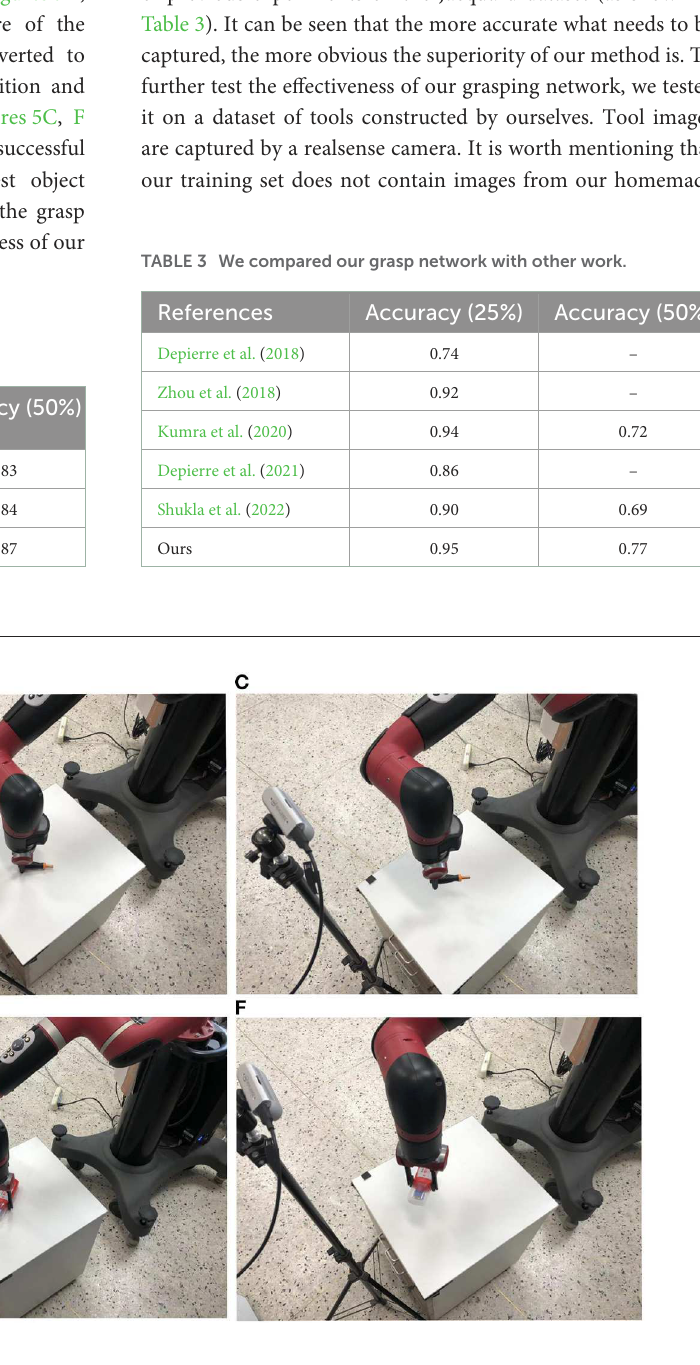
FIGURE5 Verification through robot platform. (A, D) The results of grasp detection. (B, E) The robot grasping tools. (C, F) The robot lifting tools to indicate whether the grasping is successful or